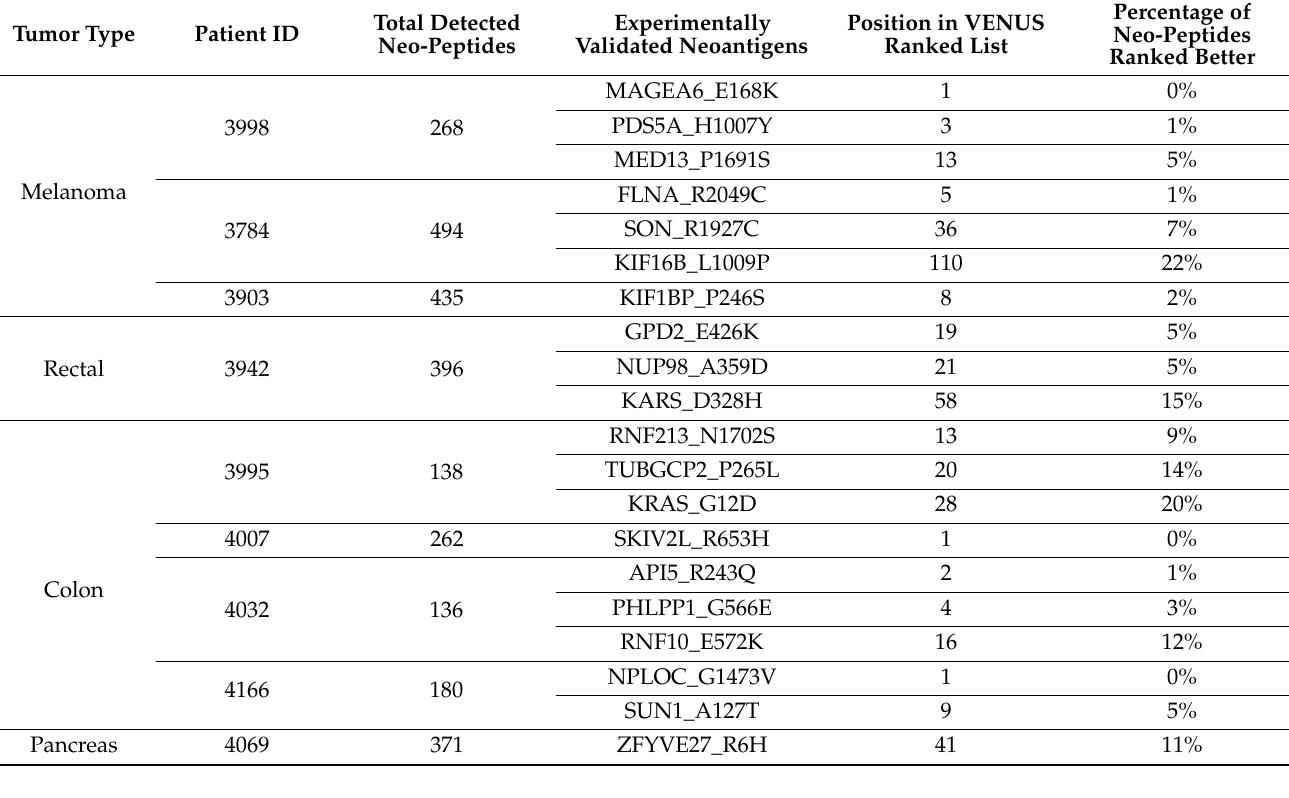
Table 1. Position of experimentally validated neoantigens in patient-specific lists of ranked according to VENUS score. For each patient, the total number of mutation-derived neo-peptides, the position of the neoantigens with validated T-cell reactivities in the protein, and the position of the neoantigen within the VENUS ranked list are reported, and for each neoantigen, the percentage of neo-peptides that were ranked with a better score is reported.